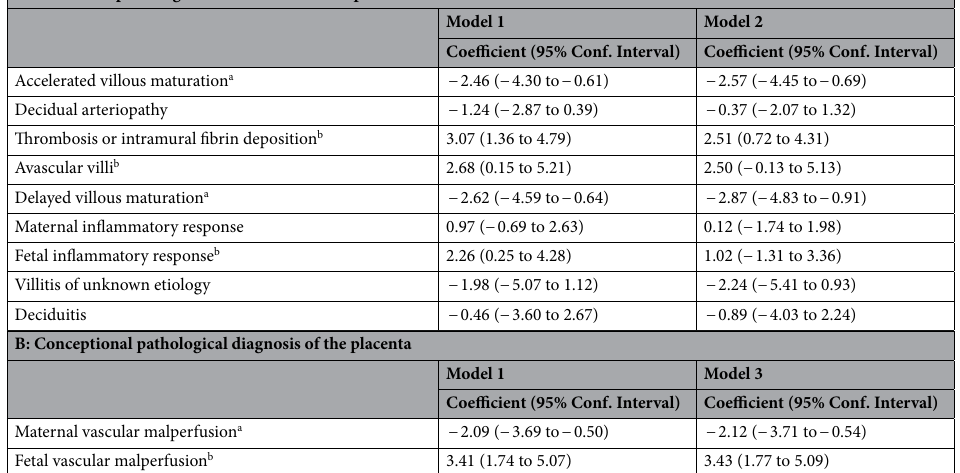
Table 3. Mixed model analysis of Total Mullen Scales of Early Learning composite scores during 10 to 40 months in individual placental pathological findings. Significance was set at a p value of 0.05 as described in the “Methods” section. A; Adjusted for ‘Accelerated villous maturation’, ‘Decidual arteriopathy’, ‘Thrombosis or Intramural fibrin deposition’, ‘Avascular villi, ‘Delayed villous maturation’, ‘Maternal inflammatory response’, ‘Fetal inflammatory response’, ‘Villitis of unknown etiology (VUE)’, and ‘Deciduitis’. B; Adjusted for ’Maternal vascular malperfusion’ or ‘Fetal vascular malperfusion’. ’Maternal vascular malperfusion’ and ‘Fetal vascular malperfusion’ were separately assessed, because diagnostic criteria of them includes some of pathological findings listed in A. The regression coefficients represent any changes associated with the presence/absence of the specific placental pathological changes, measured with the Mullen Scales of Early Learning composite score with the mean of 100 and the standard deviation of 15. Model 1; Covariates included in the analysis were maternal parity, birth weight, and infantile sex, which may be related to placental pathological findings and MSEL composite scores. Model 2; Additional covariates of all of other placental pathological findings. Model 3; Additional covariate of all of Fetal vascular malperfusion or Maternal vascular malperfusion. a Significant predictors of the relatively delayed achievement of neurodevelopmental milestones. b Significant predictors of the relatively faster achievement of neurodevelopmental